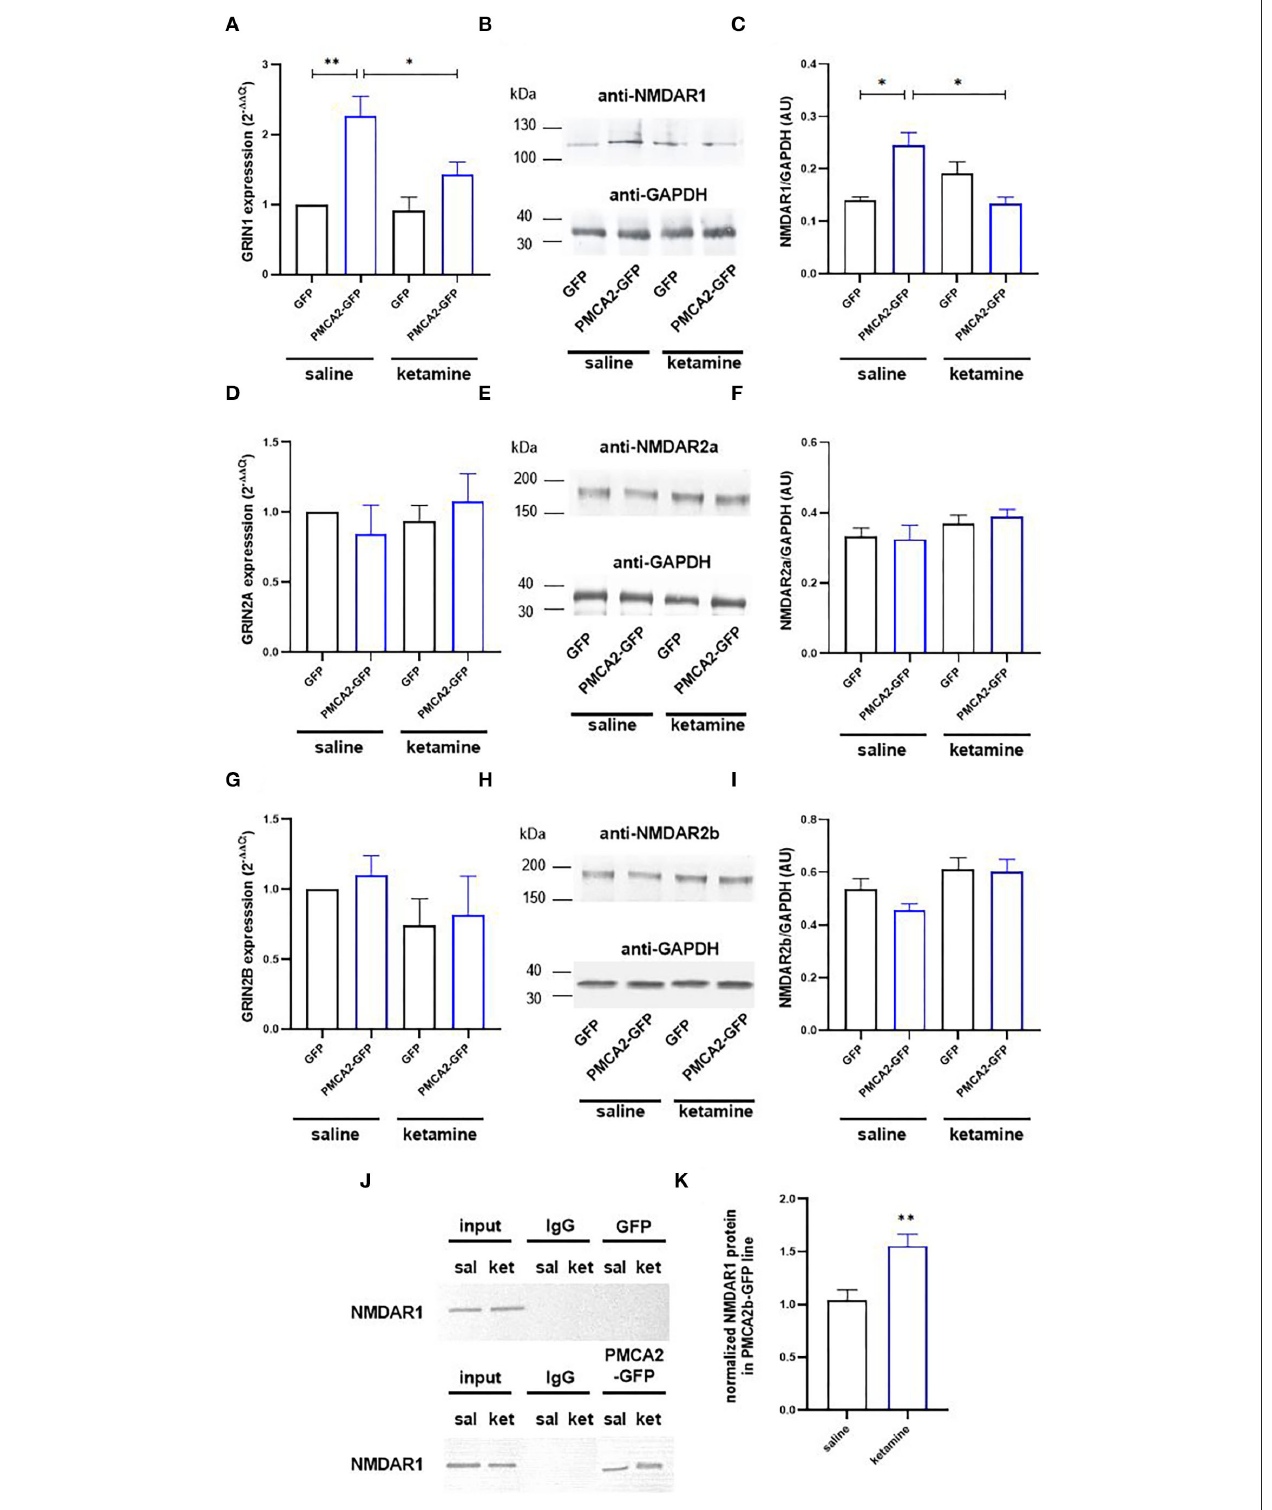
FIGURE 4 | Ketamine enhances PMCA2b interaction with NMDAR1. (A) The expression of Grin1 encoding NMDAR1 subunit evaluated with real-time PCR and calculated using the 2 − 11 Ct method. The expression level in GFP control was taken as 1, n = 4. (B) NMDAR1 protein level evaluated with the Western blot.